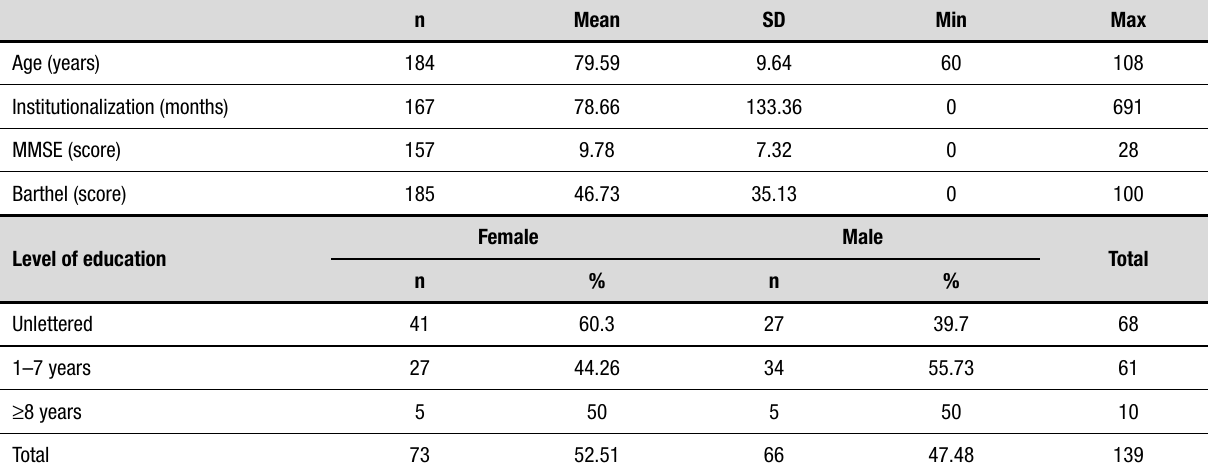
Table 1. Sample characterization and demographic